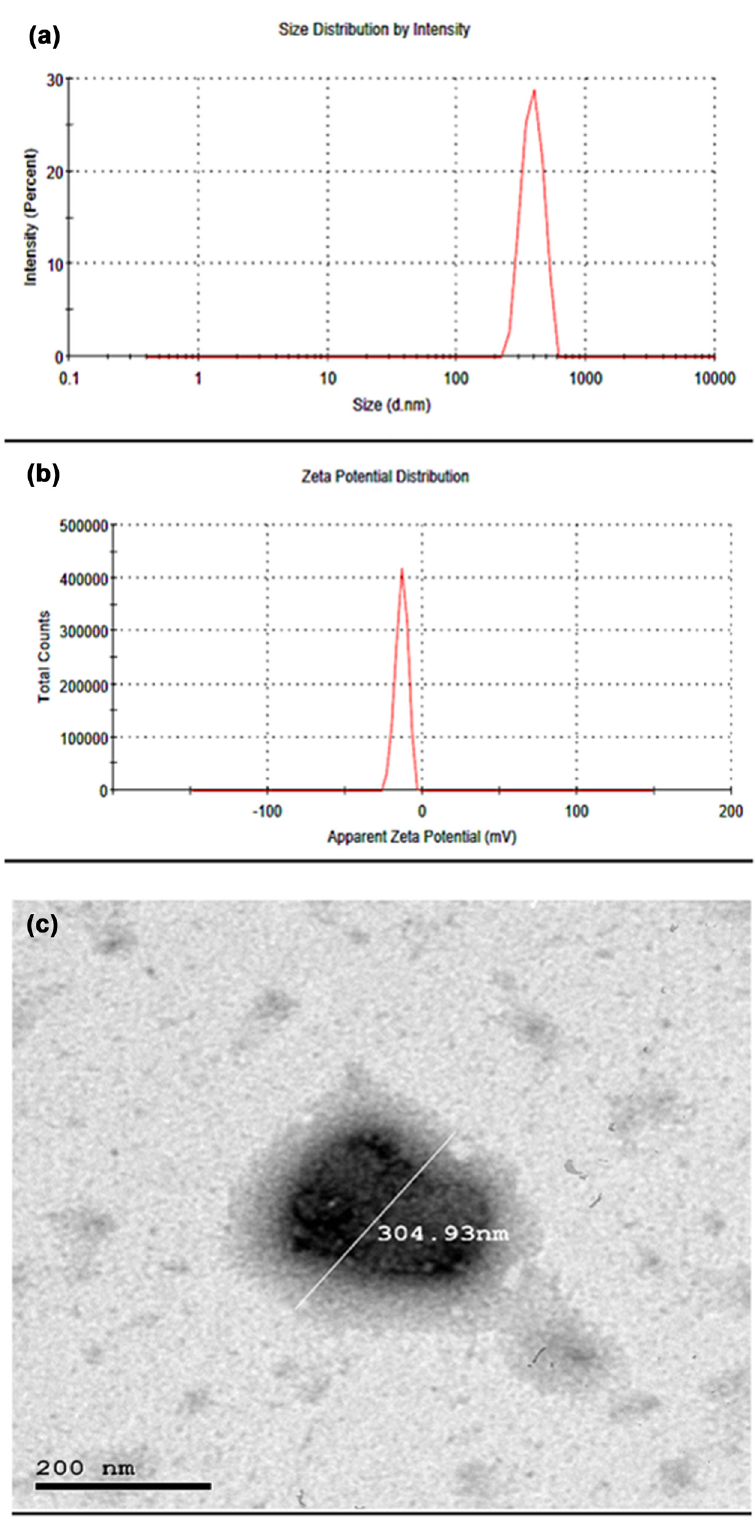
Figure 2: ( a ) SFB - NPs particle size distribution, ( b ) SFB - NPs zeta potential as measured using dynamic light scattering using Malvern zetasizer nano, and ( c ) TEM image of SFB - NPs with a well - identi fi ed spherical particle and uniform